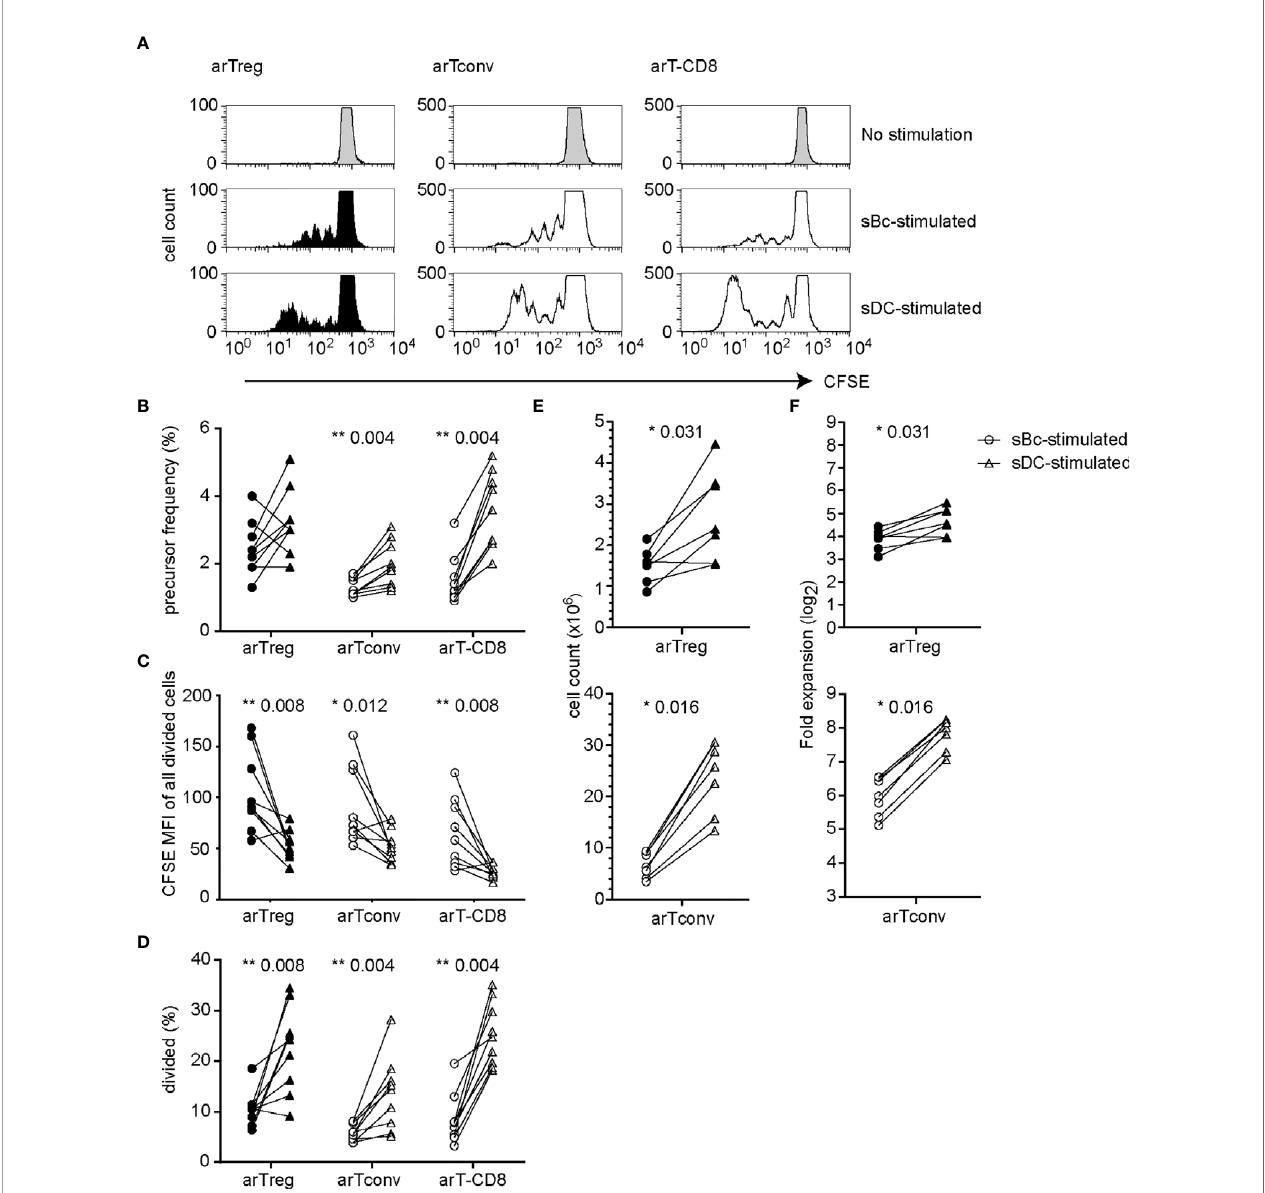
FIGURE 1 | sDCs, compared to sBcs, stimulate more alloreactive T cell proliferation. (A – D) CFSE-labeled responder PBMCs were stimulated with sBcs (2 sBcs per 1 PBMC), or sDCs (1 sDC per 4 PBMCs) for 4 days. (A) Representative histograms showing CFSE dilution/proliferation of T cells: Tregs (CD3 + CD4 + CD8 - FOXP3 + HELIOS + ), Tconvs (CD3 + CD4 + CD8 - non-Treg), and CD8 + T cells (CD3 + CD8 + CD4 - ). Histograms are zoomed in to show proliferation peaks. (B) T cell precursor frequency. (C) Divided T cells were gated as CFSE lo , and CFSE level of expression was measured by mean fl uorescence intensity (MFI). (D) Percentage of divided T cells (CFSE lo ) of total T cells. (E, F) FACS-puri fi ed Tregs (CD4 + CD127 lo/- CD25 + ) and Tconvs (CD4 + CD127 + CD25 - ) were cultured with sBcs (4 sBcs per 1 T cell), or sDCs (1 sDC per 4 T cells). arTreg (top) and arTconv (bottom) (E) cell counts on d11 and (F) fold expansion from d0 to d11. Cell counts were normalized to d0 count of 100,000. Data in (A – D) contain 9 different responder-stimulator combinations. Data in (E, F) contain 7 different responder-stimulator combinations. Connecting lines indicate alloreactive T cells stimulated by APCs (sBcs or sDCs) derived from the same donor. Statistics were performed using the Wilcoxon matched-pairs signed rank